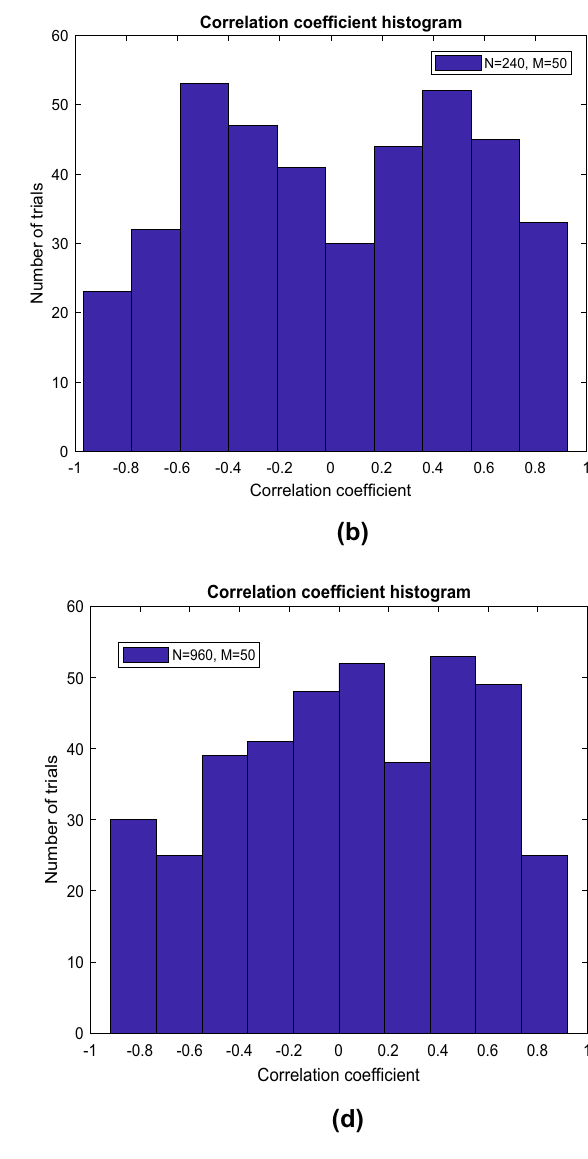
skewed towards − 1 or 1, but remain relatively uniform over the whole interval, which indicates no reliable estimation